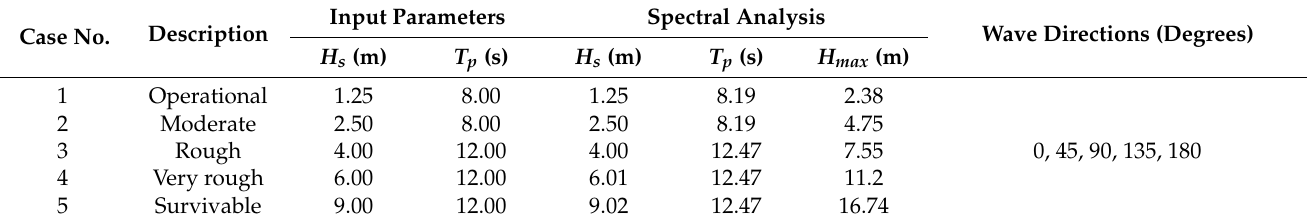
Table 8. Sea-state conditions for the FOWC mooring study.